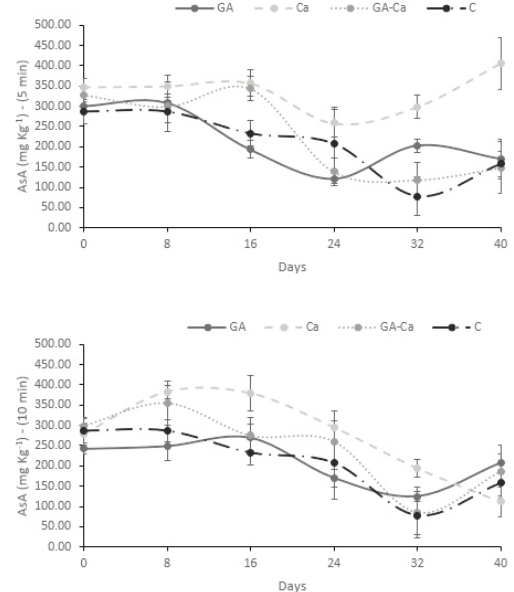
Fig. 3 ­ Effects of the treatments applied using both dipping times (5 and 10 min), on the AsA content during cold sto­ rage. Treatments: GA, Ca, mix GA­Ca, C (Control­ no use of GA and Ca). Values are the mean three replicates, and vertical bars represent ±